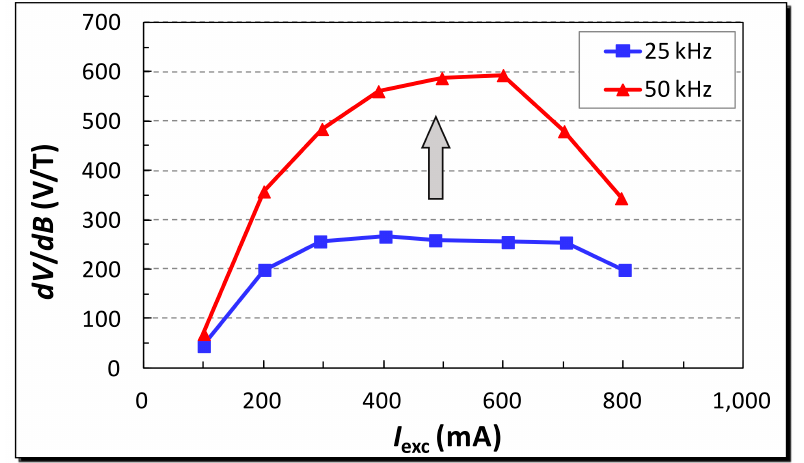
Figure 5. Responsivity of the proposed fluxgate sensor vs. the excitation current ( I various excitation